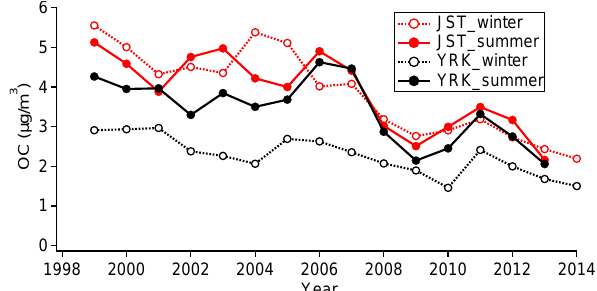
Figure 16. The seasonality of the correlation between organic car- bon and sulfate at the Jefferson Street (JST), Yorkville (YRK), and Centreville (CTR) sites. Seasons are by grouped by calendar months (spring is March–May, summer is June–August, fall is September– November, and winter is